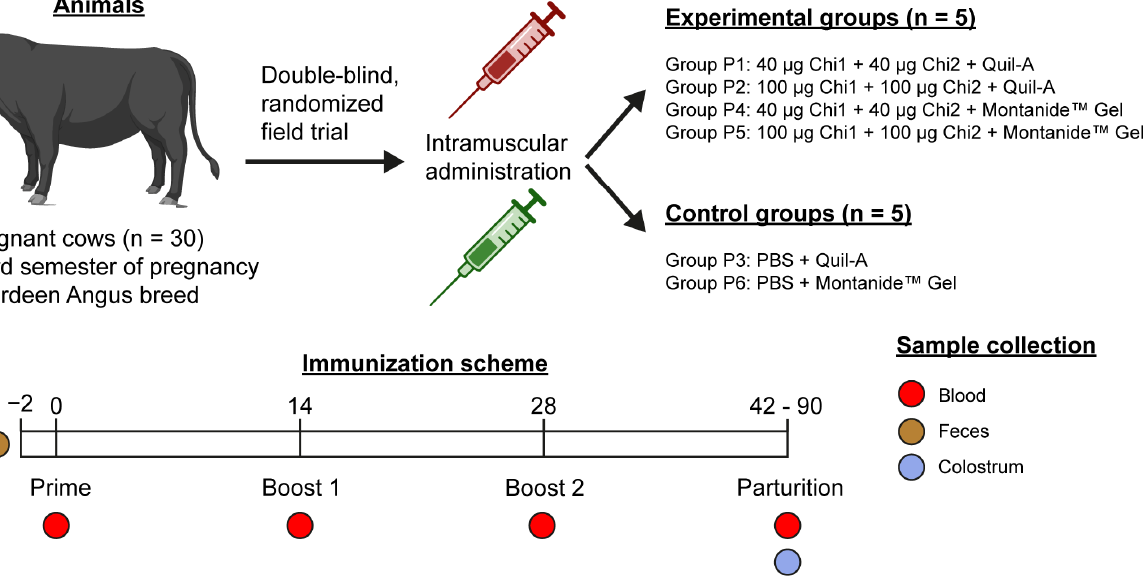
Figure 1. Experimental design of this field trial. The different groups of animals, vaccine formulations and placebos and immunization schedule are shown.